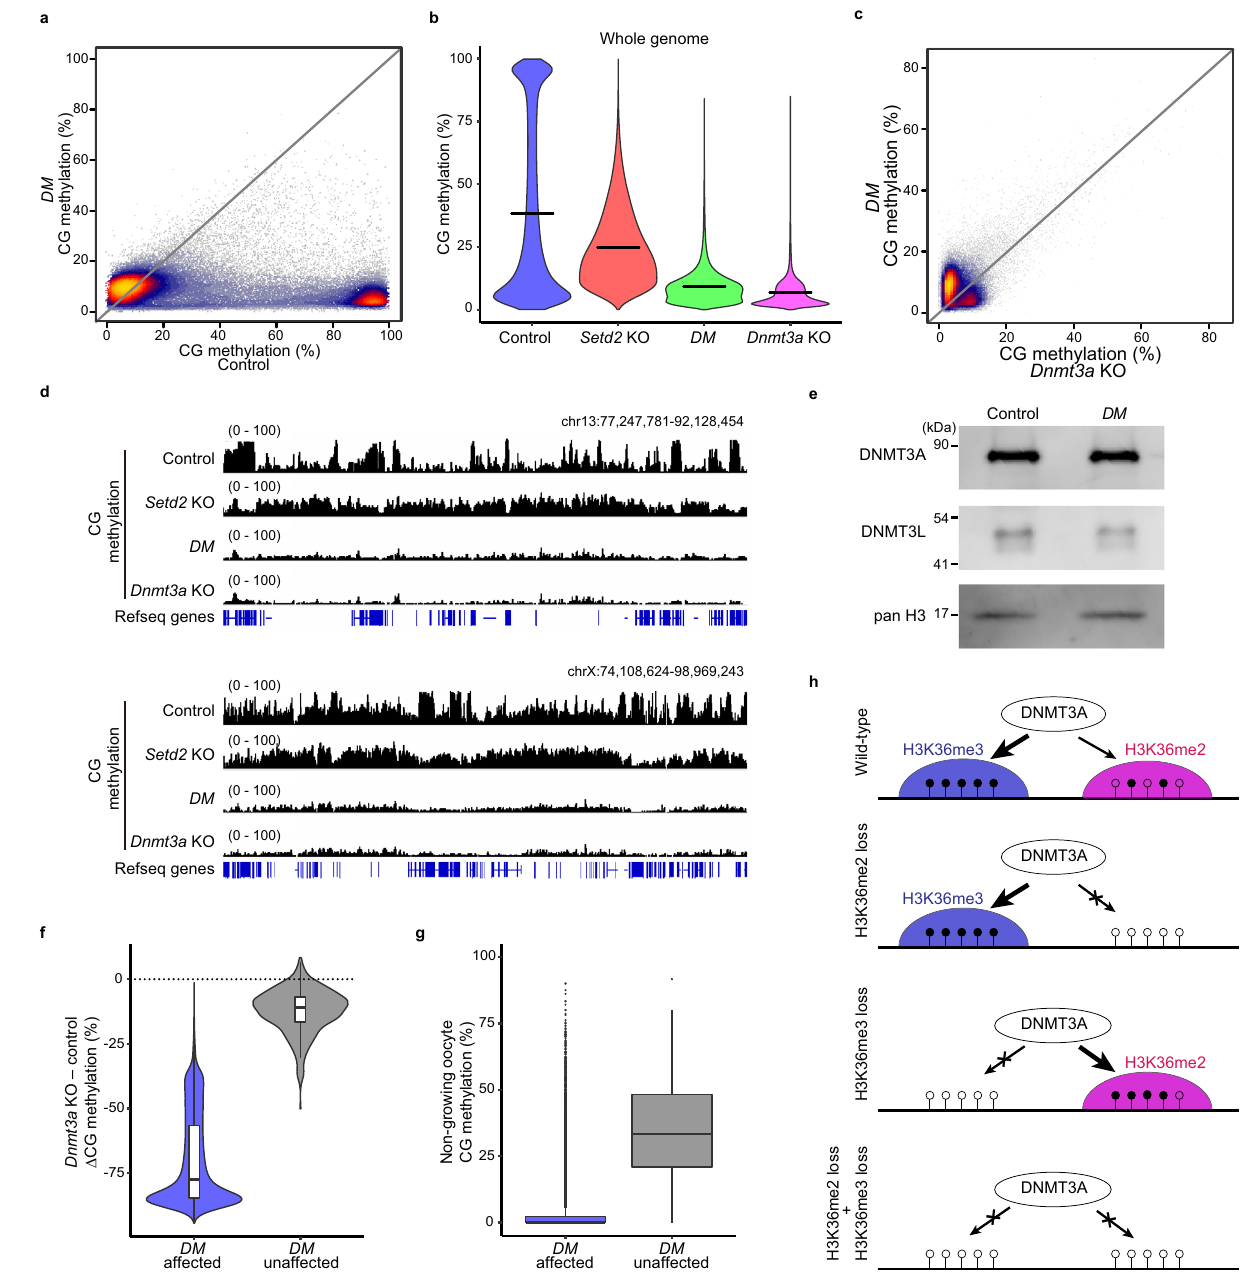
Fig. 5 | Simultaneous removal of H3K36me2 and H3K36me3 results in global hypomethylation in FGOs. a Scatter plots showing CG methylation levels in the control and DM FGOs. Fifty thousand randomly selected 10kb bins were plotted. b Violin plots showing CG methylation levels in 10kb bins across the genome in control, Setd2 KO, DM , and Dnmt3a KO 7 FGOs. Horizontal bars indicate mean values. c Scatter plot showing CG methylation levelsin Dnmt3a KO 7 and DM FGOs. Fifty thousand randomly selected 10kb bins were plotted. d Genome browser snapshots showing CG methylation levels in control, Setd2 KO, DM , and Dnmt3a KO 7 FGOs. The upper and lower panels show representative regions from chro- mosomes 13 and X, respectively. e Western blotting detecting DNMT3A and DNMT3L proteins in DM FGOs. Representative images from three biological repli- cates.Pan-H3wasusedastheloadingcontrol.SourcedataareprovidedasaSource Data fi le. f Violin plots showing CG methylation differences between Dnmt3a KO 7